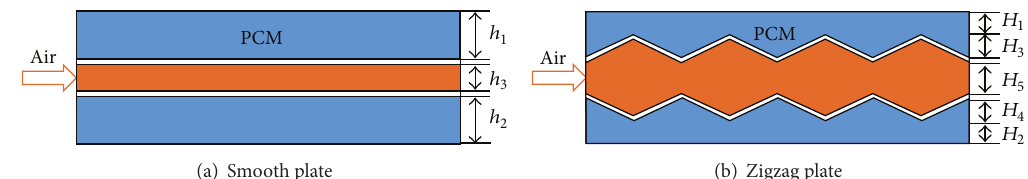
Figure 1: The schematic of the LHTES unit.